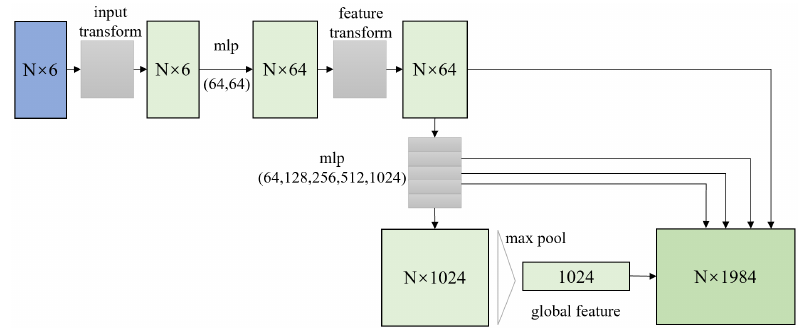
Figure 8. Network structure of the PointNet module.